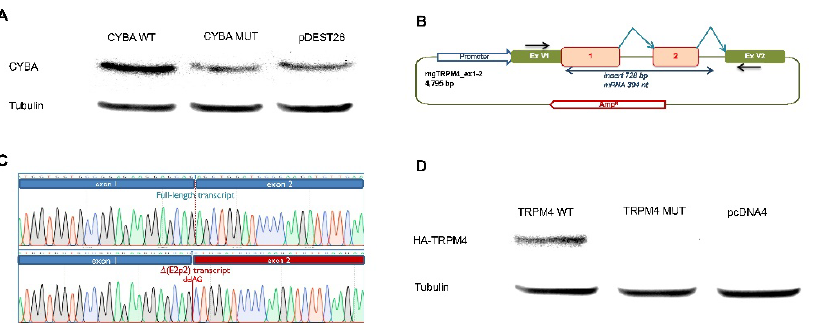
Figure 2. CYBA c.246delC and TRPM4 c.25-1G > T variants led to loss of the corresponding proteins. ( A ) Western blot detection of the CYBA protein in HEK293T transfected with wild-type (CYBA WT), mutated (CYBA MUT) or control plasmids (pDEST26). HEK293T cells transfected with the mutant CYBA plasmid expressed less protein compared to cells transfected with the wild-type CYBA plasmid. CYBA c.246delC-transfected cells expressed a similar amount of protein to those transfected with pDEST26 only. ( B ) Outline of the TRPM4 minigene construct. The black arrows in vector exons V1 and V2 indicate specific RT-PCR minigene primers; broken arrows represent the expected splicing reactions. ( C ) Sequencing traces of the transcripts generated by the wild-type (above) and mutant (c.25-1G > T) minigenes, suggesting that TRPM4 c.25-1G > T led to a frameshift transcript r.25_26del, that would be equivalent to c.25delAG. ( D ) TRPM4 c.25delAG led to the loss of TRPM4 protein. Western blot of TRPM3-HA Tag antibody in HEK293T cells transfected with wild-type, mutated or control plasmids. HEK293T cells transfected with pcDNA4TO-HA-TRPM4 c.25delAG (TRPM4 MUT) and pcDNA4 did not express any HA-TRPM4; only HEK293T cells transfected with wild-type pcDNA4TO-HA-TRPM4 (TRPM4 WT)-expressed